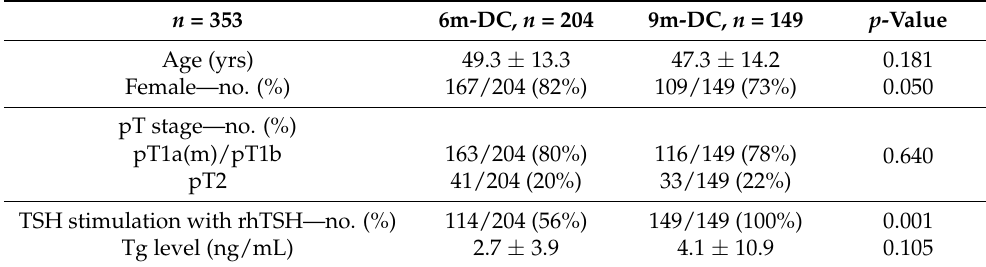
Table 1. Patient characteristics of groups (6m-DC vs. 9m-DC). n = 353 6m-DC, n = 204 9m-DC, n = 149 p -Value Age (yrs) 49.3 ± 13.3 47.3 ± 14.2 0.181 Female—no. (%) 167/204 (82%) 109/149 (73%) 0.050 0.640pT1a(m)/pT1b 163/204 (80%) 116/149